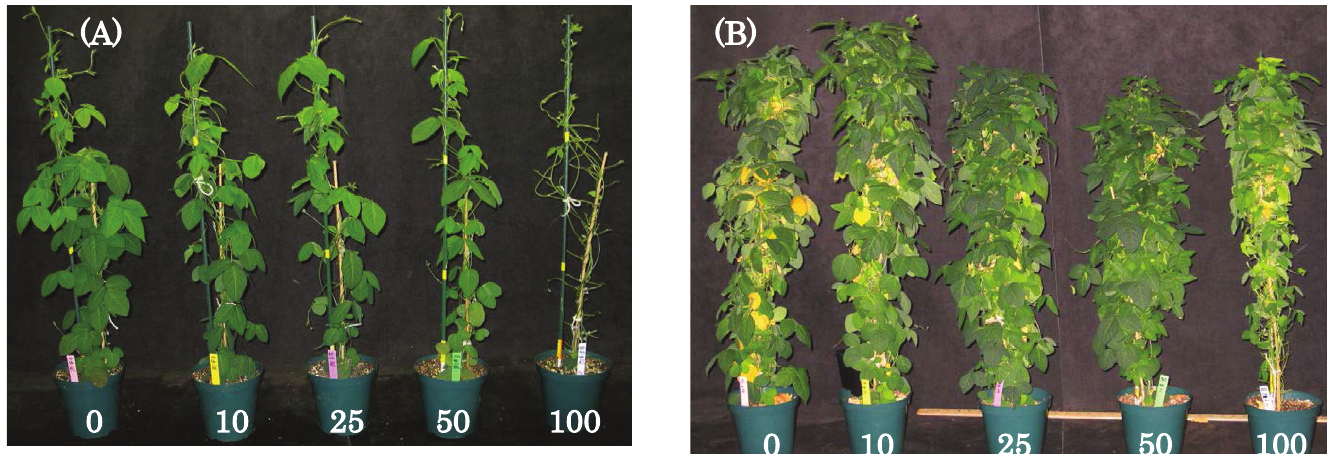
Fig 4. Example of wild soybean plants at R1-R2 growth stage just prior to defoliation treatments (A) and after defoliaton treatments at the R7 growth stage (B). The number in the figure denotes the percentage of mechanical defoliation. No defoliation (0%) treatment was used as the control.